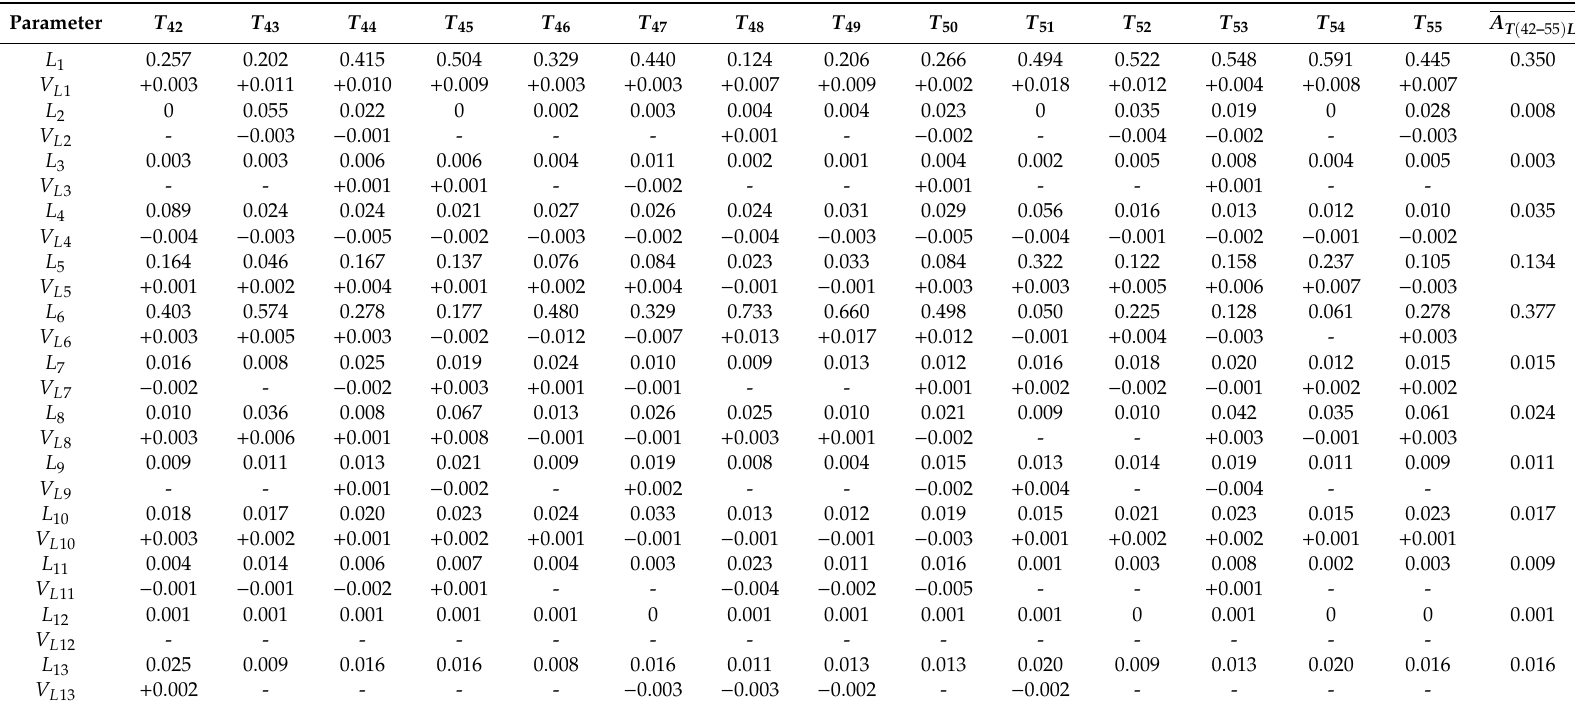
Table A13. Activity per land category in Russia, Volga Federal District. Mean values for